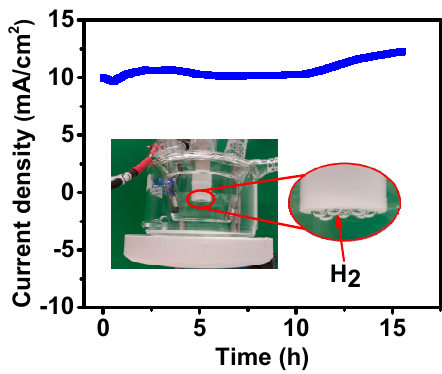
Figure 7. Time-dependent current density curve for MoS 2 -CNFs (inset shows the evolution of hydrogen during chronoamperometric measurements).